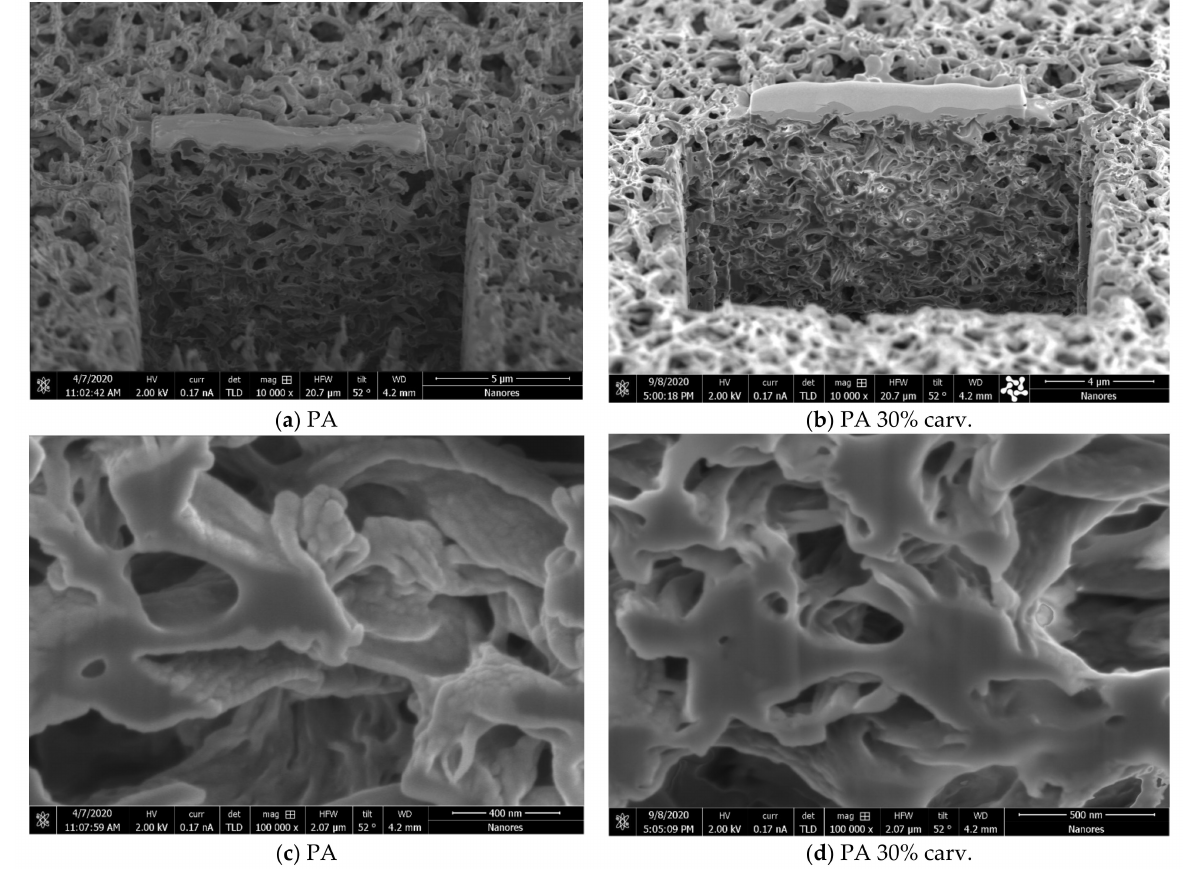
Figure 9. SEM images of cross sections of a neat polyamide membrane (PA) and polyamide membrane with 30 wt.% carvacrol (PA 30% carv.). In micrographs ( a – d ), bar values are 5 µ m, 4 µ m, 400 nm, and 500 nm,